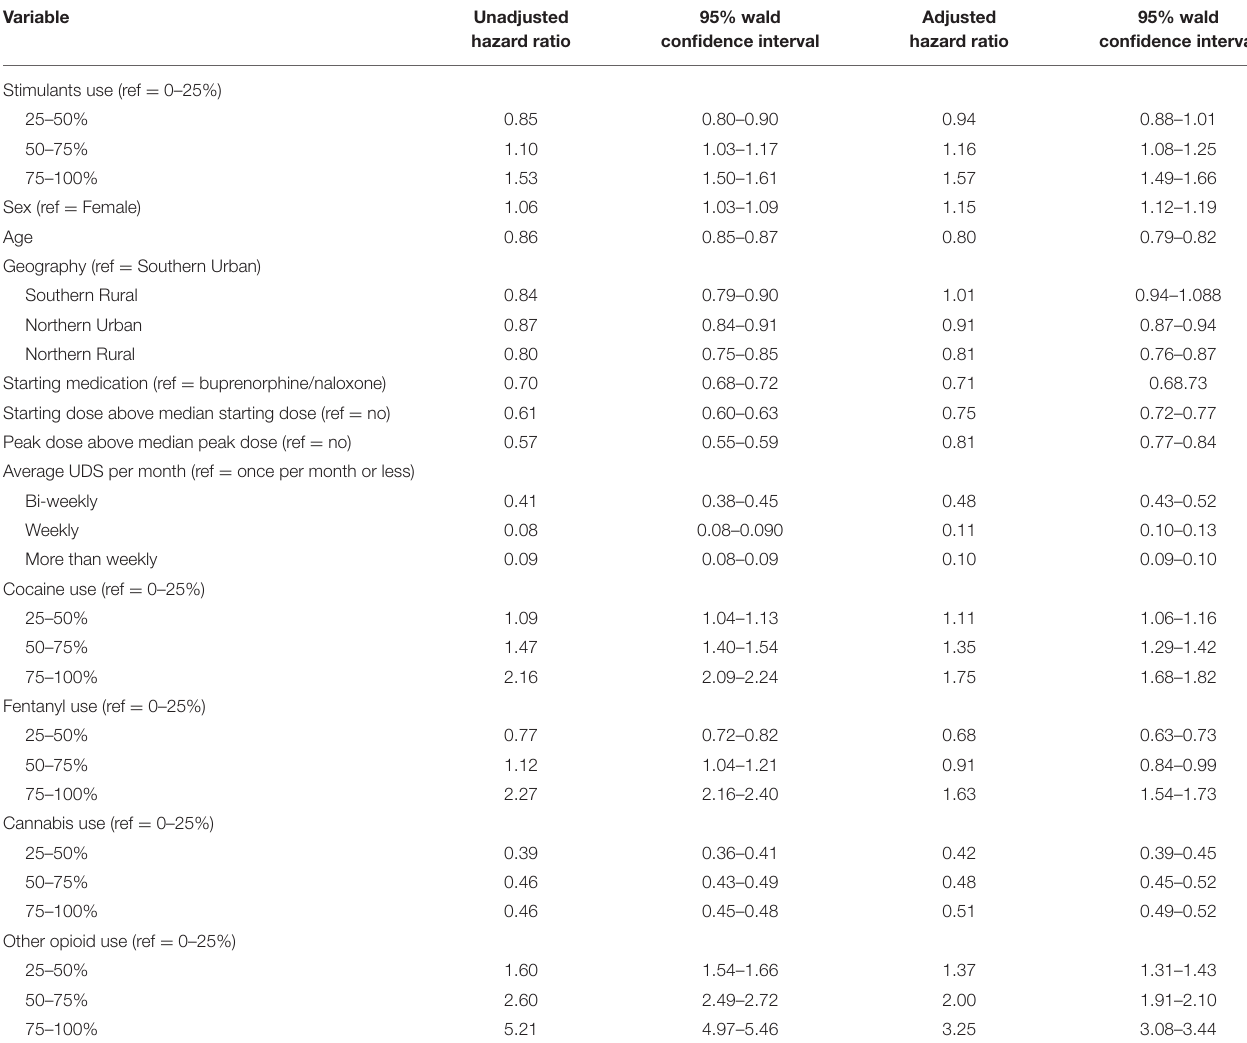
TABLE 3 | Unadjusted and Adjusted discontinuation probability (Hazard Ratio) between the amphetamine-type stimulant group, patient characteristics, clinical and drug use factors among individuals in OAT in Ontario, Canada.